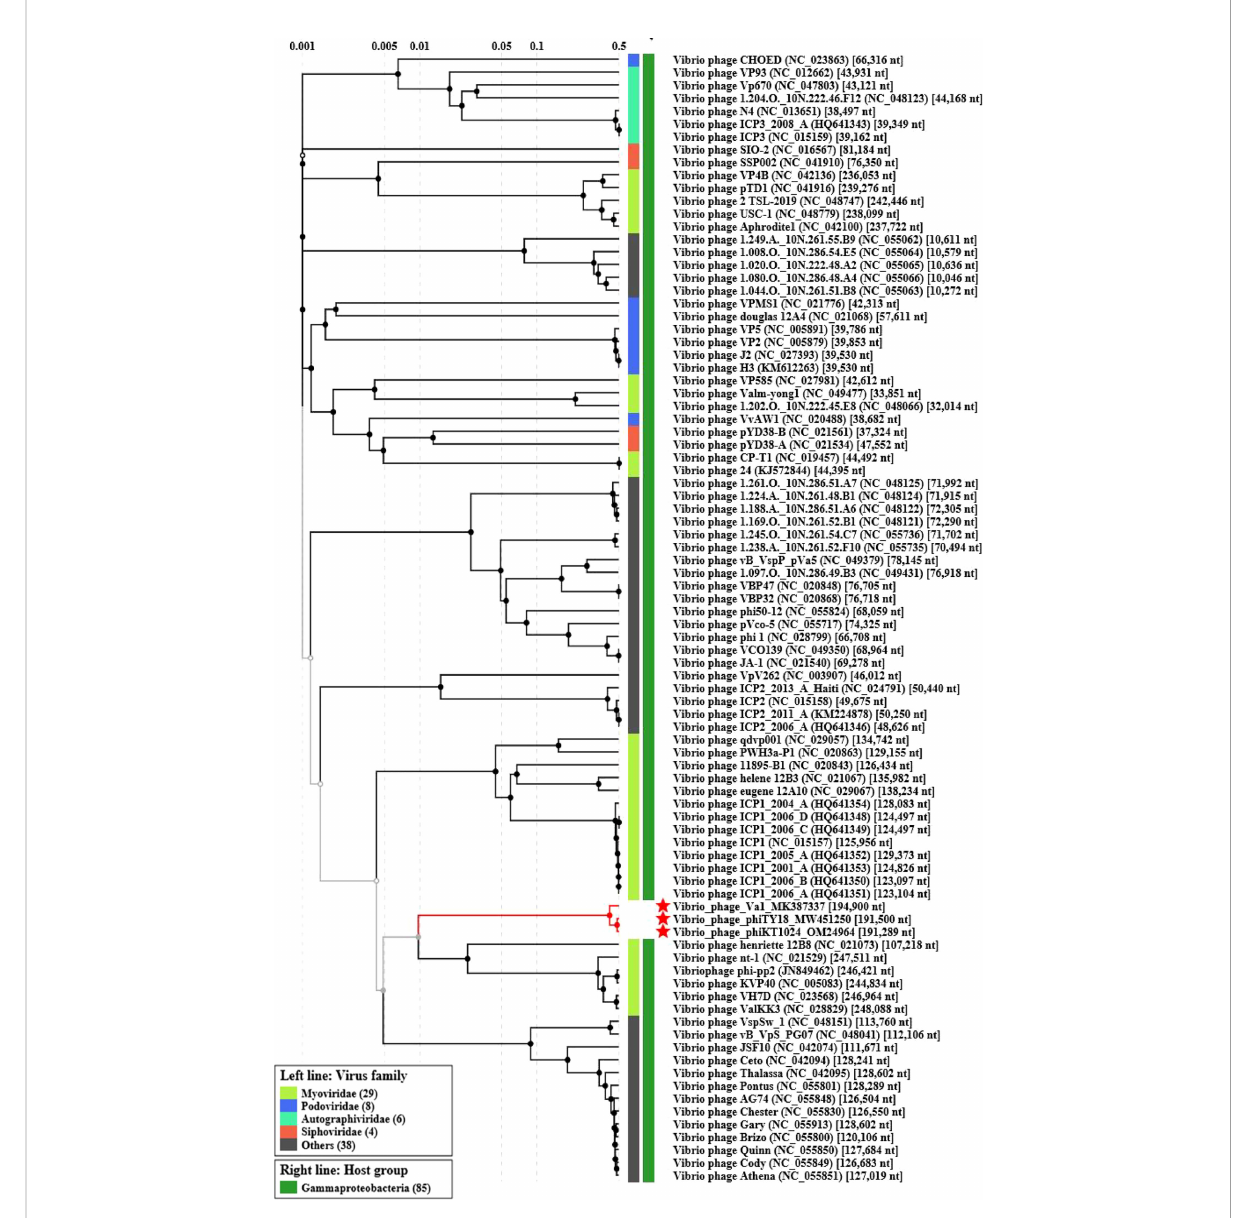
FIGURE 7 Proteomic tree analysis of Vibrio phage. Phages phiTY18, Va1, and phiKT1024 were labeled with a red star